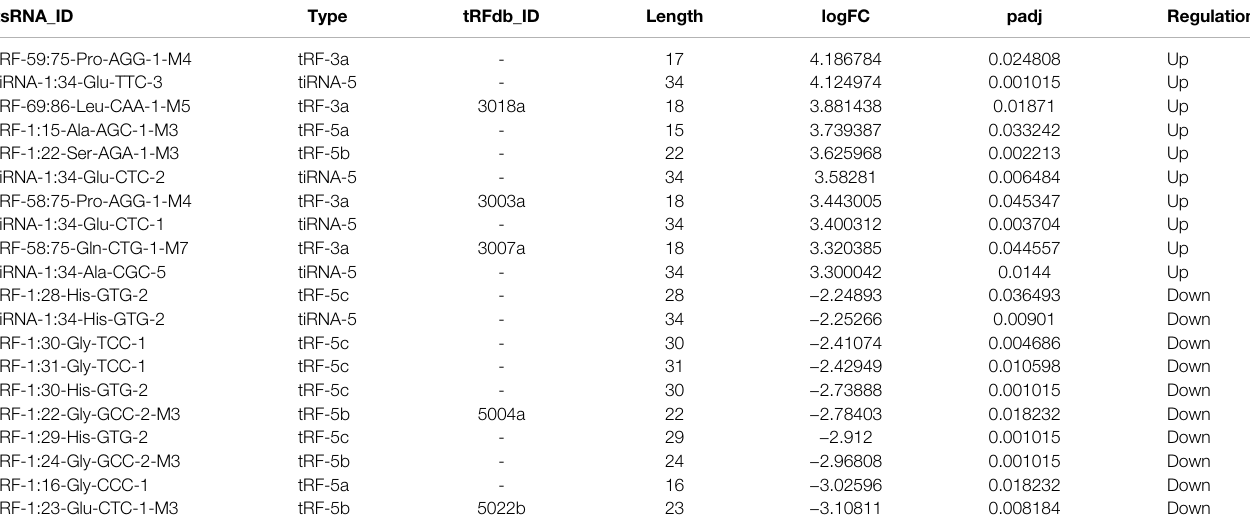
TABLE 1 | The top 10 up-regulated and down-regulated tsRNAs ranked by logFC after Cd exposure.